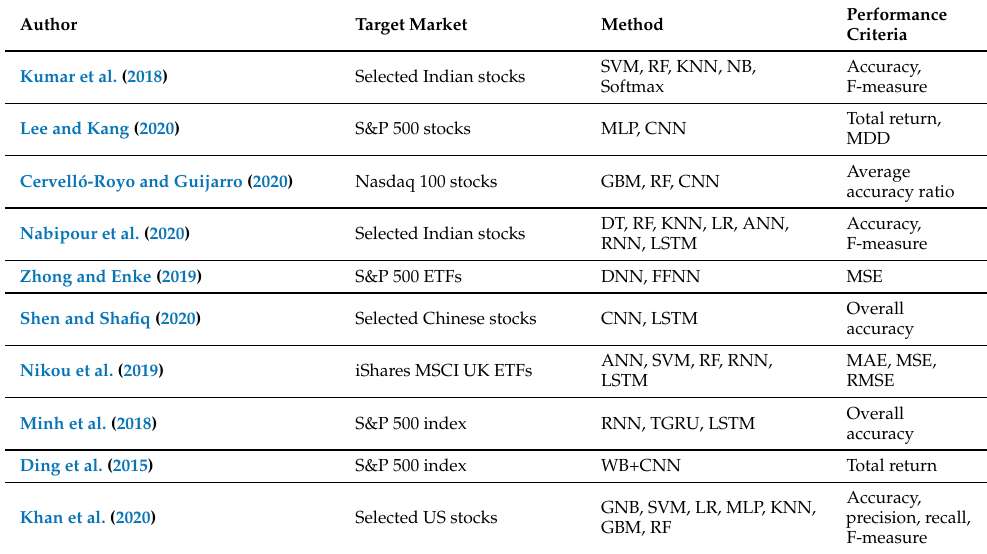
Table 5. Selection of papers for price forecasting. Mean Absolute Error (MAE), Mean Standard Error (MSE), Maximum Drawdown